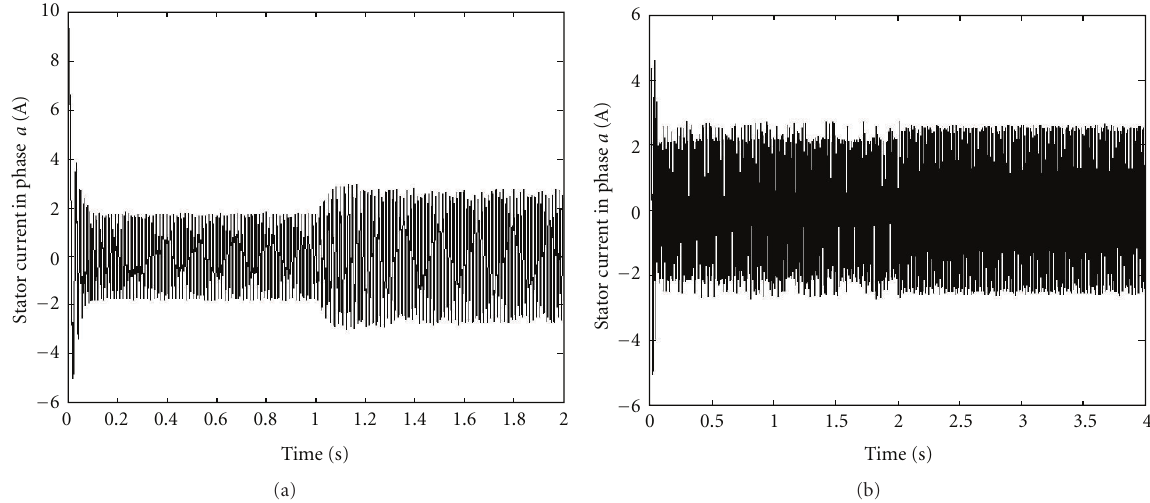
Figure 9: (a) Simulated current of IPMSM drive for flux-weakening control with reference speed 220 rad/sec using fuzzy controller with sudden load applied. (b) Simulated current of IPMSM drive for flux-weakening control with reference speed 220 rad/sec using fuzzy controller with sudden load applied.